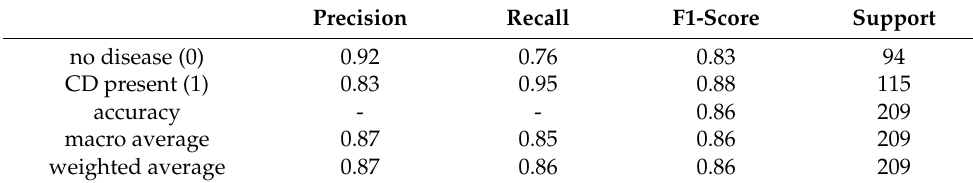
Table 5. Metrics for the random forest Machine Learning model for CD prediction.